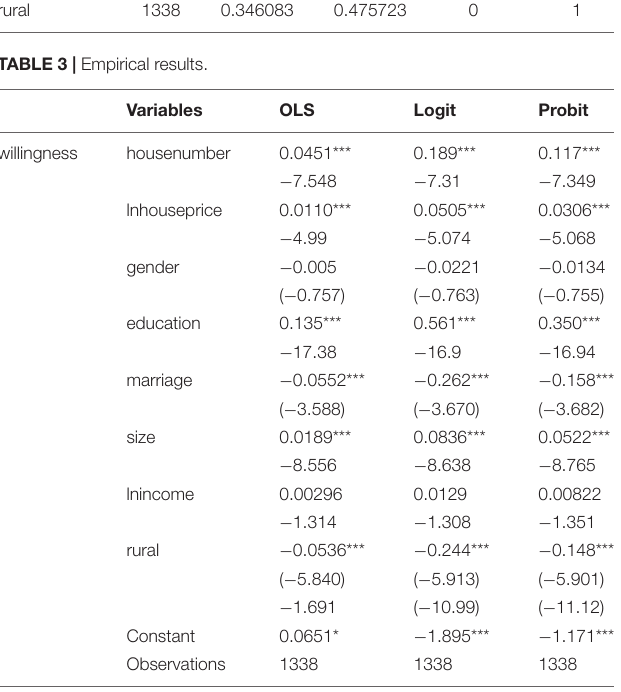
TABLE 3 | Empirical